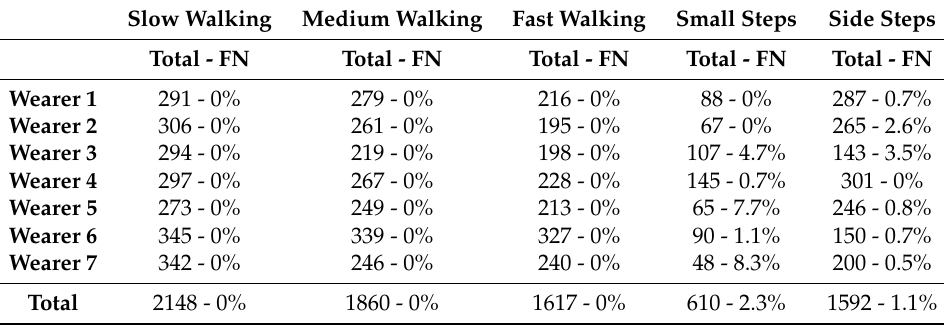
Table 2. False negative rates in motion capture (MOCAP)